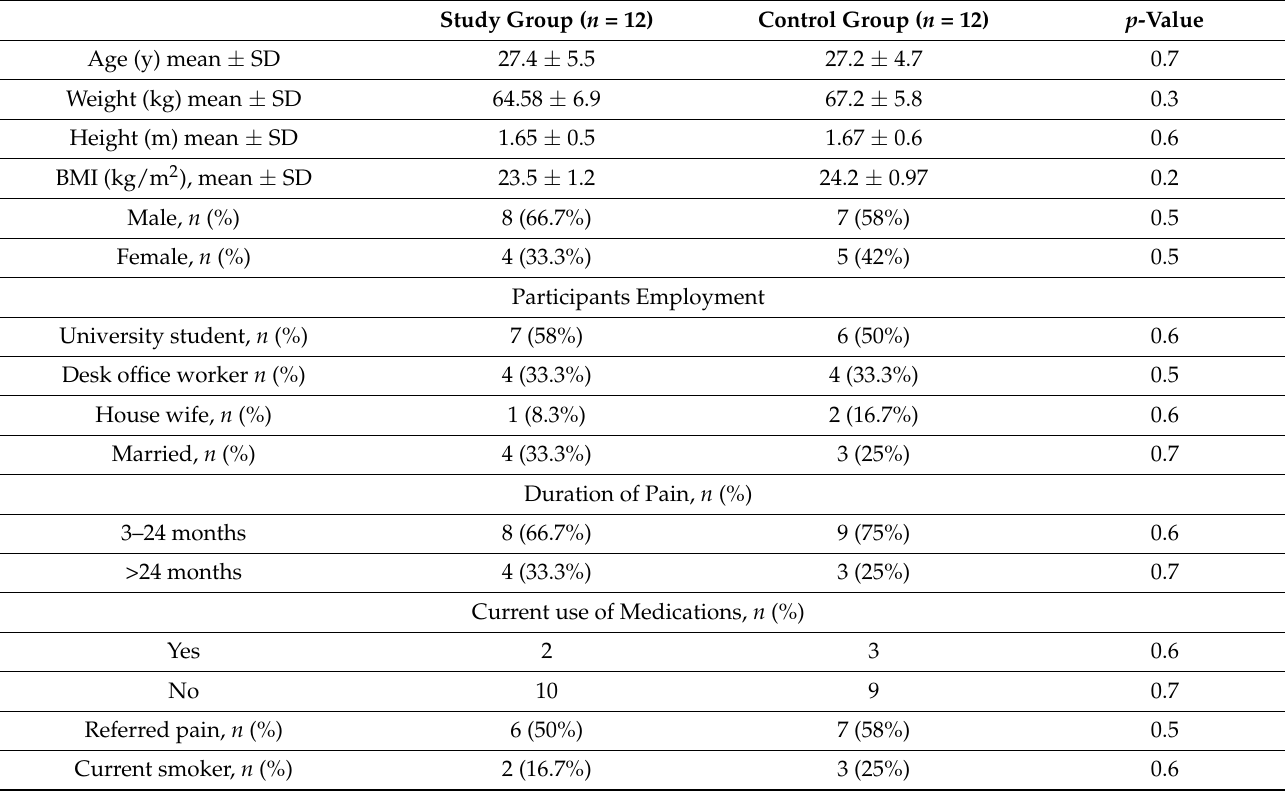
Table 4. Demographic characteristic data of